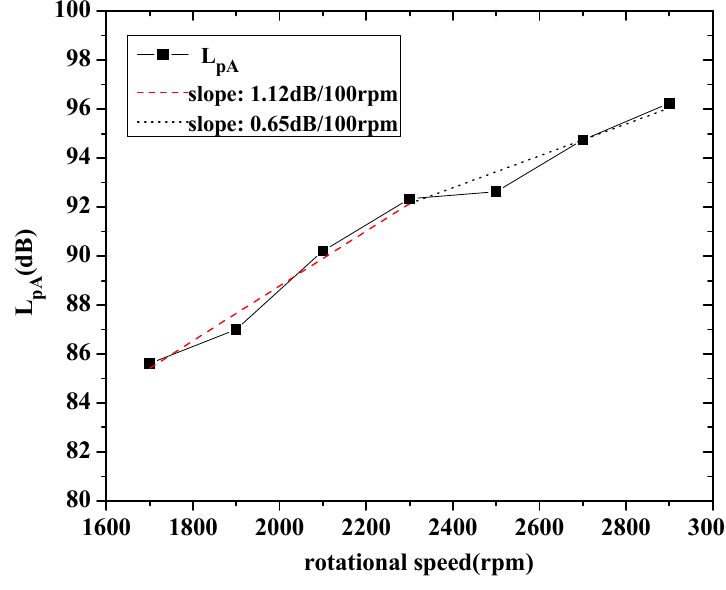
Figure 8. L pA changing curve with rotational speed .